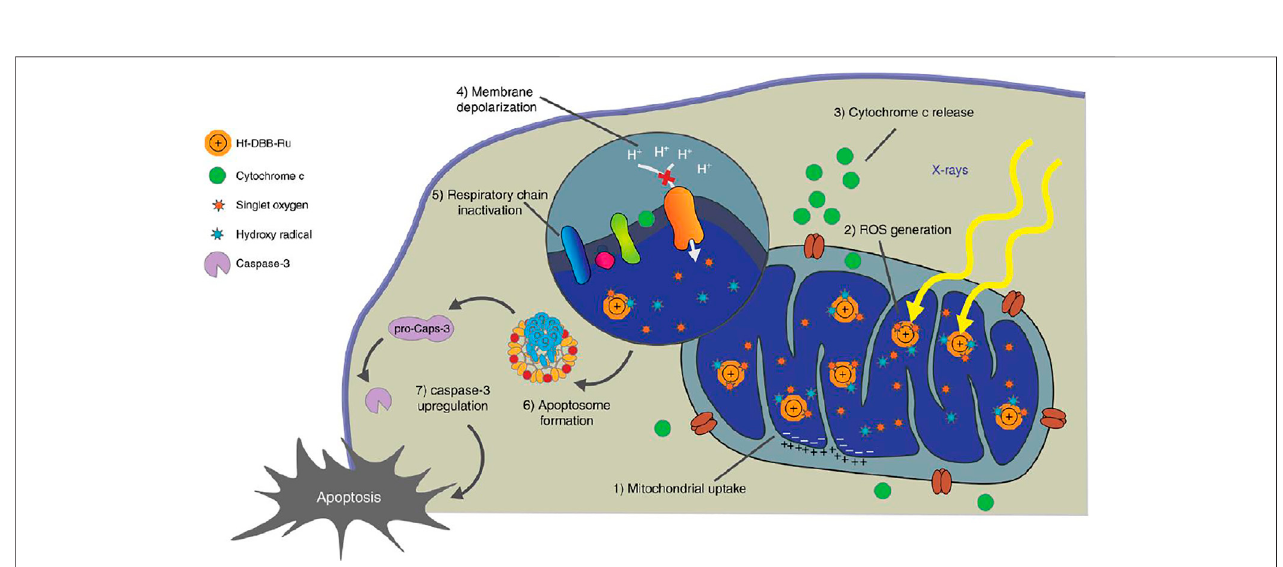
FIGURE 6 | Mitochondria-targeted RT-RDT mediated by Hf-DBB-Ru. Hf-DBB-Ru was internalized by tumor cells ef fi ciently and enriched in mitochondria due to dispersed cationic charges in the nMOF framework. Hf 6 SBUs preferentially absorb X-rays over tissues to enhance RT by sensitizing hydroxyl radical generation and enable RDT by transferring energy to Ru(bpy) 32+ -based bridging ligands to generate singlet oxygen. The RT-RDT process trigger mitochondrial membrane potential depolarization, membrane integrity loss, respiratory chain inactivation, and cytochrome c release to initiate apoptosis of cancer cells. Reproduced with permission from Ni et al. (2018). Copyright (2018)